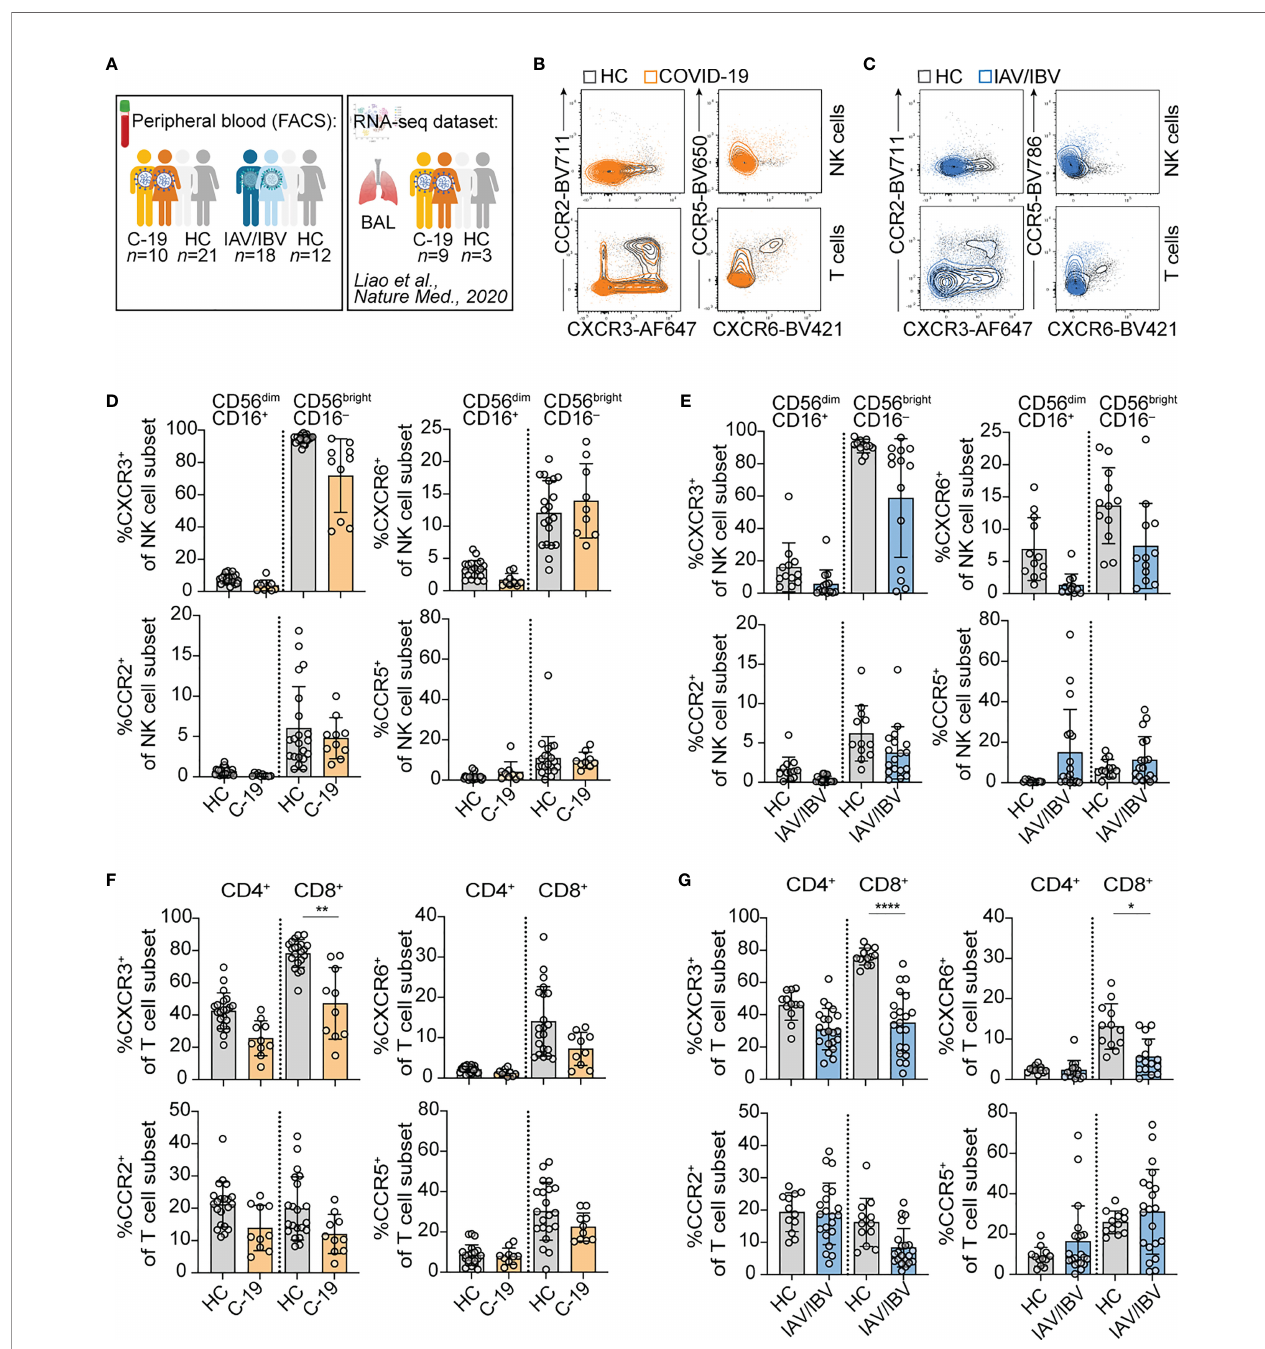
FIGURE 1 | Altered composition of NK cells and T cells expressing different lung-homing receptors in peripheral blood in acute viral infection. (A) Schematic overview of study design. In brief, blood was collected from healthy controls, and from patients infected with SARS-CoV-2 or in fl uenza A virus (IAV) or in fl uenza B virus (IBV). Additionally, a publicly available RNA-seq dataset from BAL- fl uid from COVID-19-infected patients published by Liao et al. (7) was re-analyzed. Figure created with BioRender.com (B, C) Representative overlays of NK cells (upper rows) and T cells (lower rows) of peripheral blood in a healthy control (HC) and a (B) COVID-19 patient or (C) an in fl uenza patient, displaying expression of lung-homing receptors. (D-G) Summary of chemokine receptor expression on (D, E) CD56 dim CD16 + and CD56 bright CD16 - NK cells of (D) COVID-19 patients (C-19) or (E) in fl uenza patients (IAV/IBV) (C-19: n = 10; IAV/IBV: CXCR3: n = 14; CXCR6: n = 12; CCR2: n = 18; CCR5: n = 18. HC: n = 12), or on (F, G) CD4 + and CD8 + T cells of (F) COVID-19-patients or (G) in fl uenza patients (C-19: n = 10; IAV/IBV; CXCR3: n = 18; CXCR6: n = 13; CCR2: n = 18; CCR5: n = 18. HC: n = 12). (D-G) Wilcoxon matched-rank test. *p < 0.05, **p < 0.01, ****p <